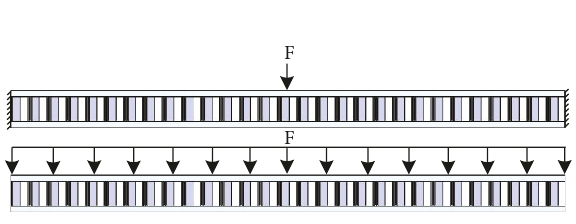
Figure 5: Surface pressure 10 MPa.